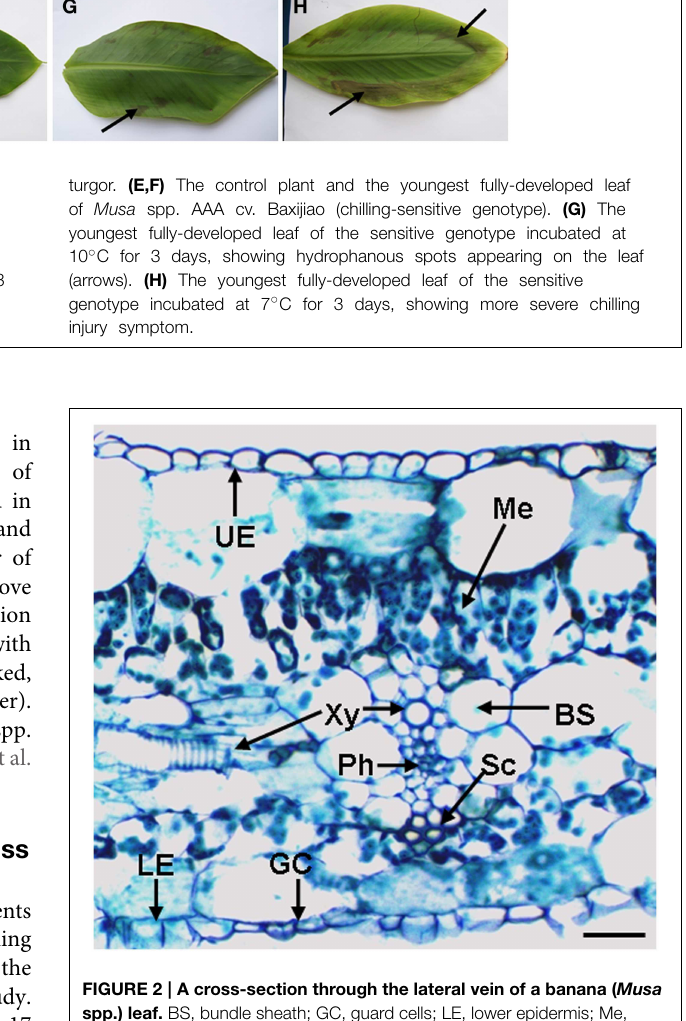
FIGURE 2 | A cross-section through the lateral vein of a banana ( Musa spp.) leaf. BS, bundle sheath; GC, guard cells; LE, lower epidermis; Me, mesophyll; Ph, phloem; Sc, sclerenchyma cells; UE, upper epidermis; and Xy, xylem vessel. The bar represents 50 µ